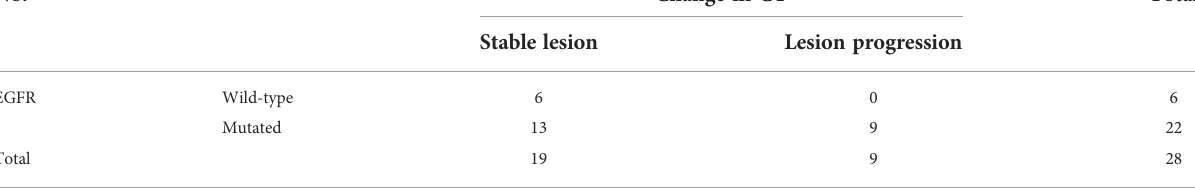
TABLE 3B Correlation of EGFR and change in CT imaging of fi rst time to follow up. No. Change in CT EGFR Wild-type